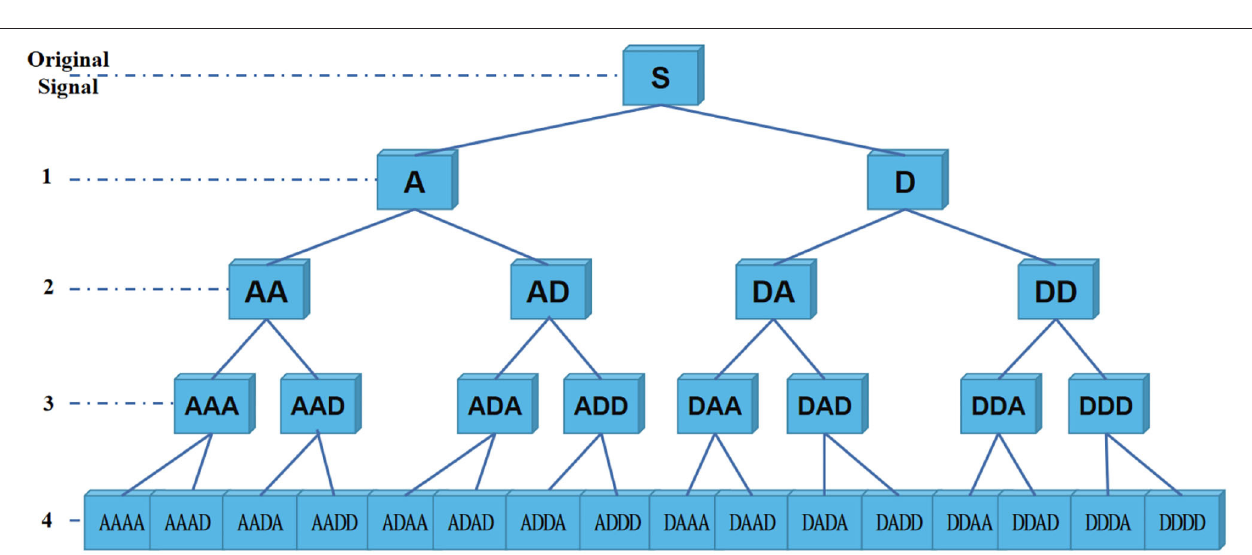
and they provided an algorithm for constructing fast local filters in spectral domain, which can learn local, static and combined features on graph. Subsequently, Kipf and Welling (2016) optimized convolutional network structure through the first-order local approximation of spectrogram